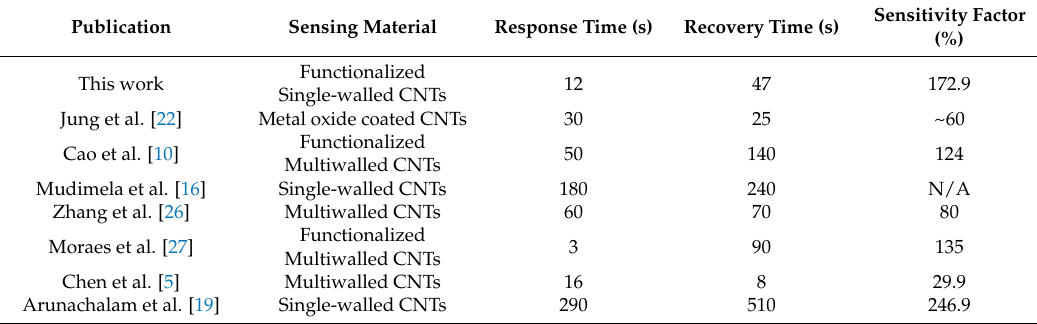
Table 1. Comparison of the response and recovery times of different CNT humidity